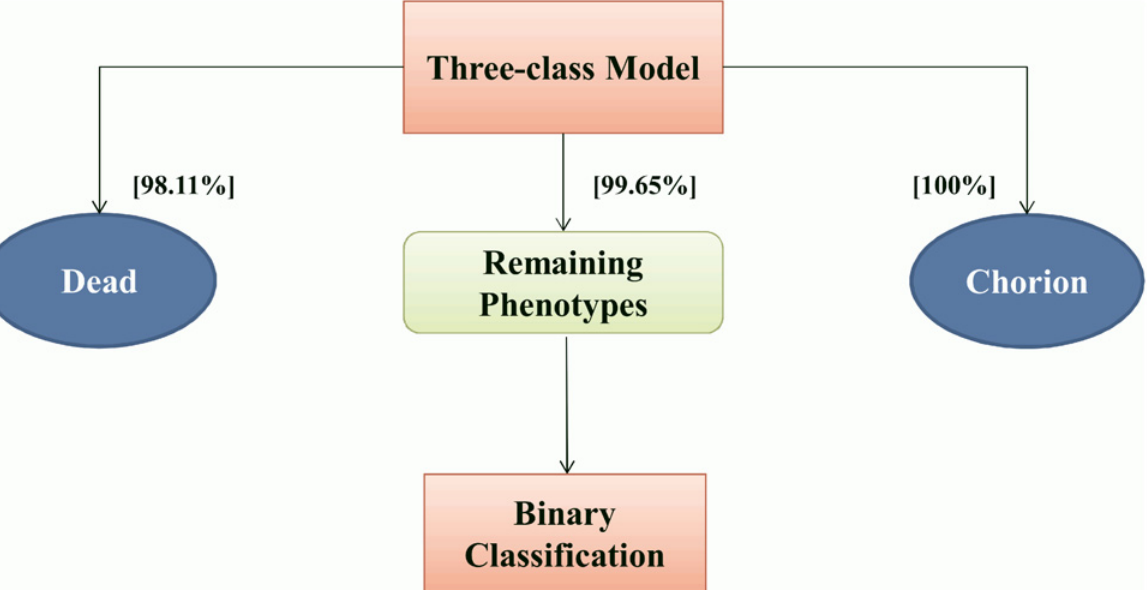
Figure 3. Two-tier pipeline. Schematic overview of the Two-tier approach for classification, also showing the recognition rates observed on the test set for the three-class